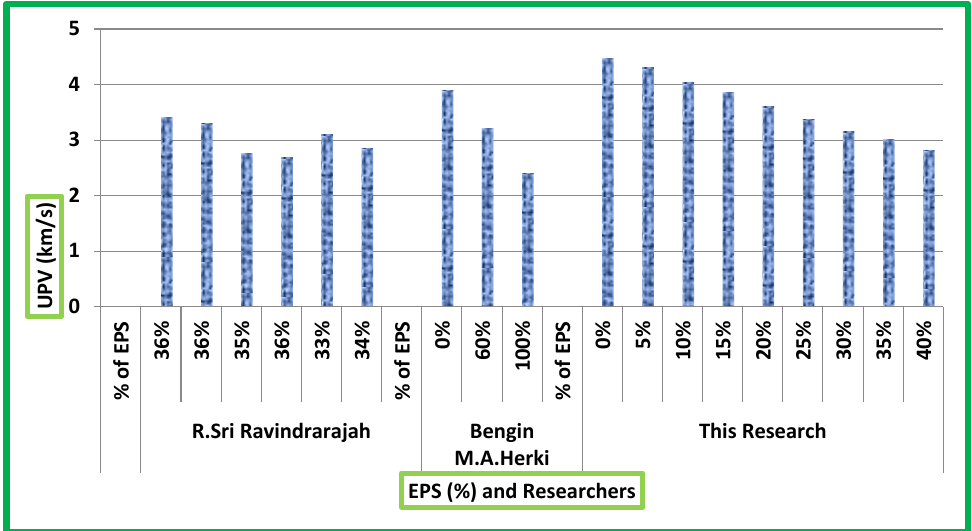
Figure 12. Comparative analysis of UPV of this study with Ravindrarajah, R. Sri [59], and Herki, B.[2].